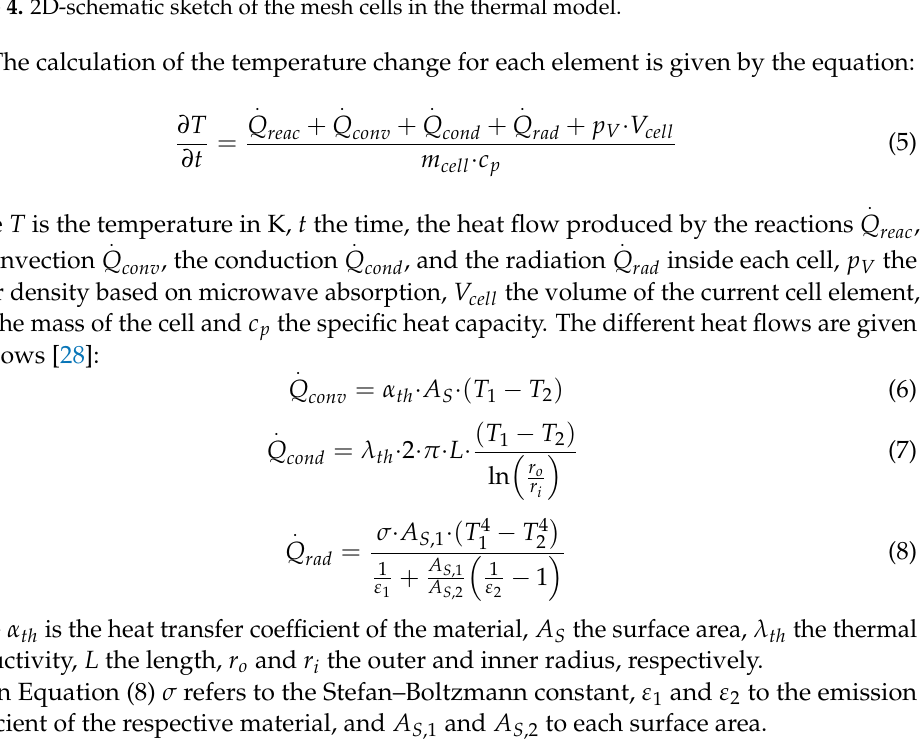
Figure 4. 2D-schematic sketch of the mesh cells in the thermal